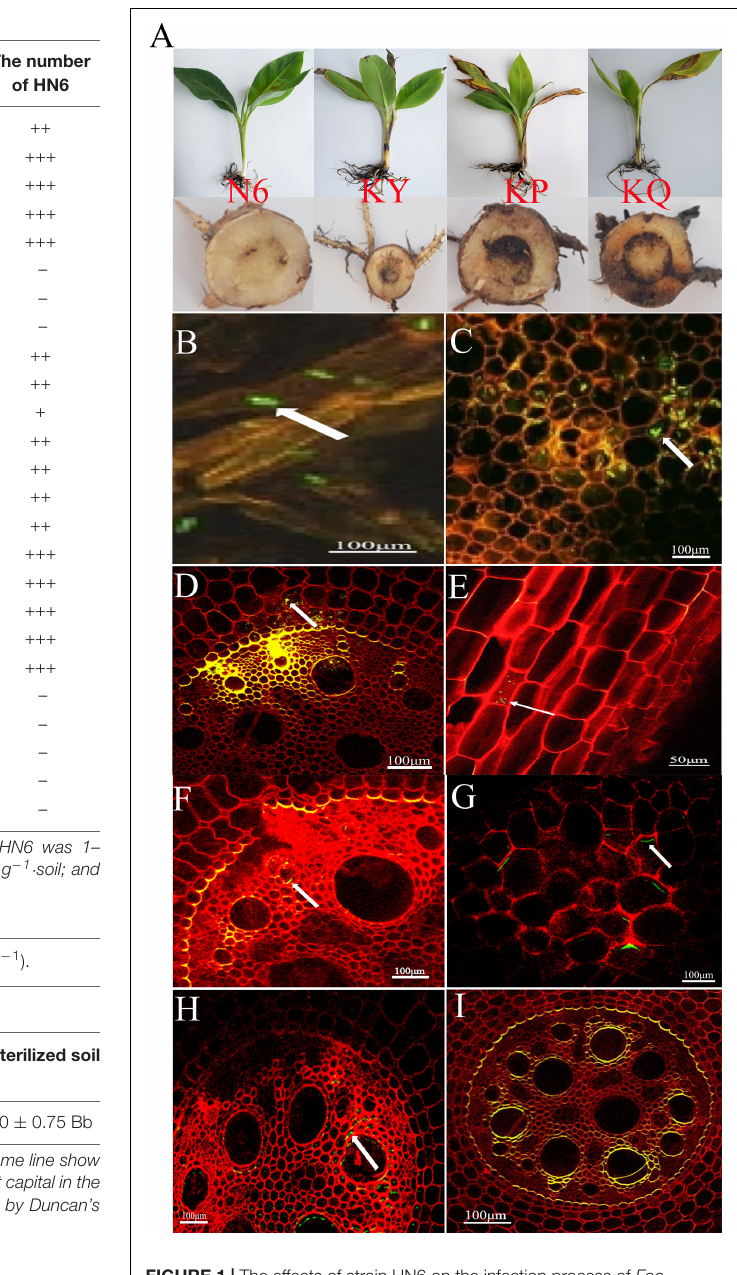
FIGURE 1 | The effects of strain HN6 on the infection process of Foc TR4-GFP. N6 ( Foc · TR4-GFP + HN6, 1.0 × 10 7 cfu g − 1 soil), KY ( Foc · TR4-GFP + 0.1% carbendazim), KP ( Foc · TR4-GFP + Gause No. 1 liquid medium), and KQ ( Foc TR4-GFP + sterile water). YS referred to rhizosphere soil of uninoculated plants. (A) Susceptible banana seedlings. (B) At the first day postinfection, hyphae and spores adhered to root hair and root epidermis of the KQ bananas. (C) At the seventh day postinfection, Foc TR4-GFP spores were observed on the root hairs and also in the parenchymal cells of the KQ banana roots. (D) At the 11th day postinfection, the hyphae extended upward along root vascular bundles to corms of the KQ bananas. (E) Direct penetration of epidermal cells of the KQ bananas roots at the 15th day; (F,G) N6 and KY groups: at the 15th day, no hyphae were found in the corm central cylinder tissues of the bananas; KP and KQ groups: (H,I) at the 15th day, hyphae and spores adhered to the corm central cylinder tissues of the